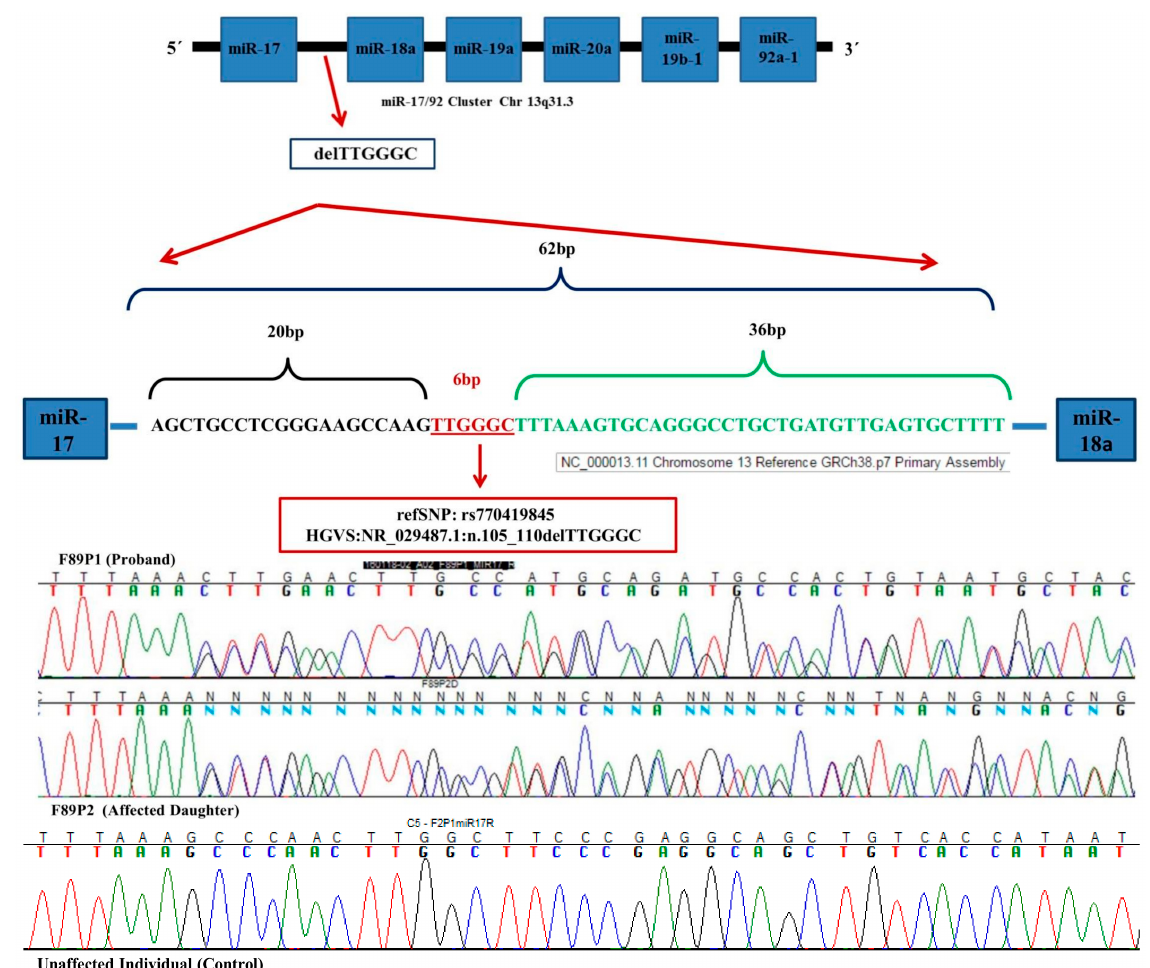
Figure 1. Location, genomic context, and identification by Sanger Sequencing of delTTGGGC (rs770419845) in the polycistronic miR-17–92 cluster. Partial electropherogram showing the deletion in both the proband (F89P1) and her daughter (F89P2). The overlapping peaks occur because both affected individuals are heterozygous for the variant. At the bottom, partial electropherogram of an individual without the deletion (normal homozygous).